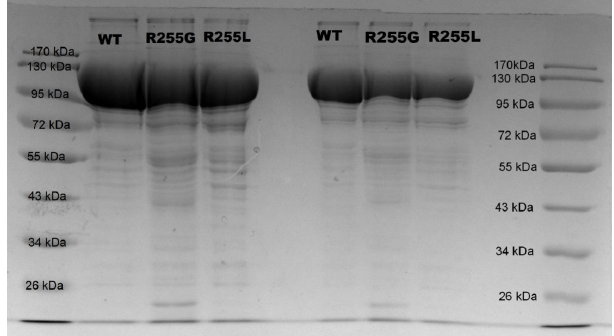
Figure A10. SDS-PAGE (10% Acrylamide) analysis of the purified P450 BM3 WT and variants R255G and R255L. The molecular weight of P450 BM3 WT and variants proteins are ca. 118 kDa.